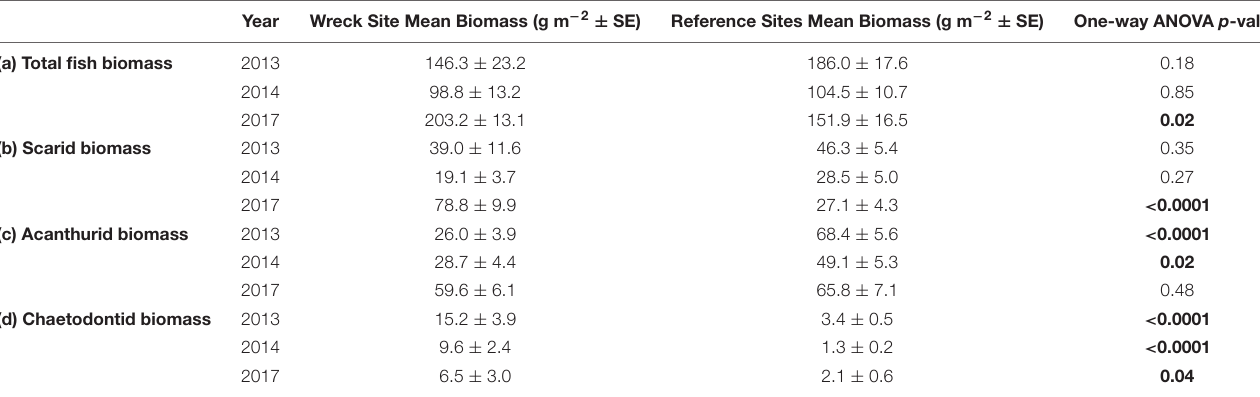
TABLE 2 | Results of one-way ANOVAs comparing the mean transect-level biomass values from the wreck site to reference sites in 2013, 2014, and 2017 for (a) total fish (excluding sharks and jacks), (b) scarids, (c) acanthurids, and (d) chaetodontids.